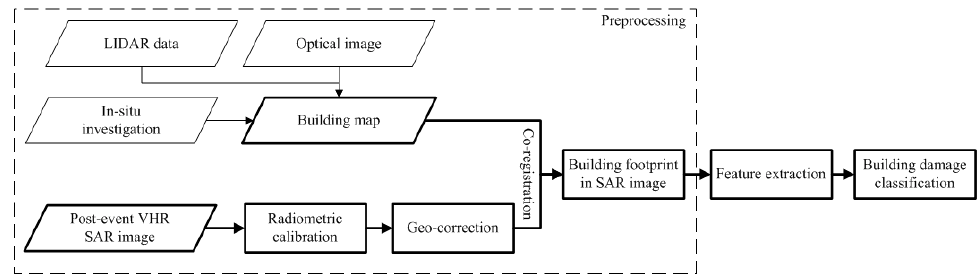
Figure 7. Block scheme of the proposed methodology.